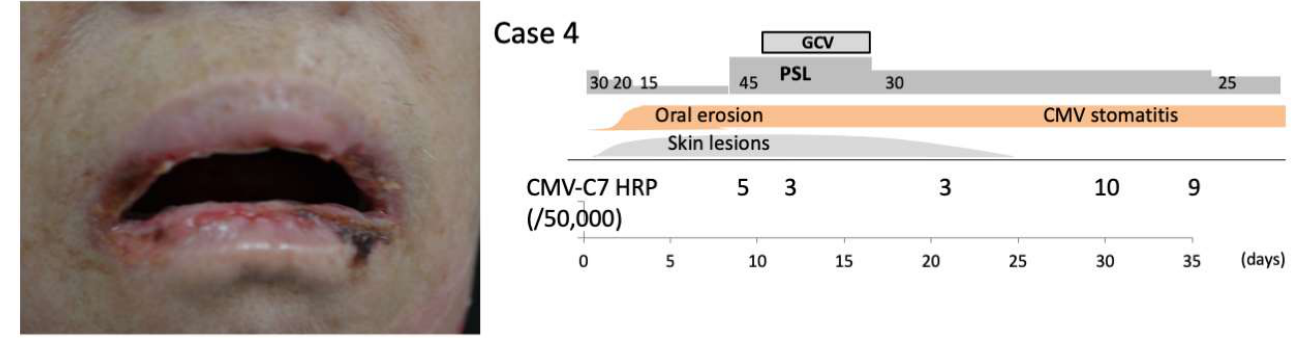
Figure 4. Case 4: Intraoral erosions due to pemphigus and its clinical course. Skin biopsy revealed CMV infection as a complication.